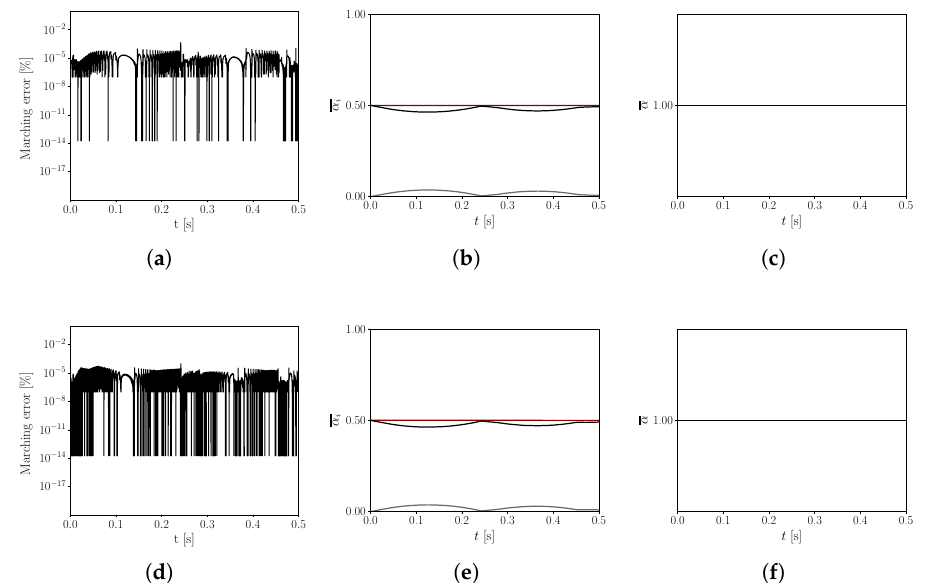
Figure 15. Evolution in time of ( a , d ) marching error; ( b , e ) volume-weighted void fractions; ( c , f ) sum of the volume-weighted void fractions. Grid A: ( a – c ); grid B ( d – f ). Legend: α l ( ), α v ( ), α nc ( ).